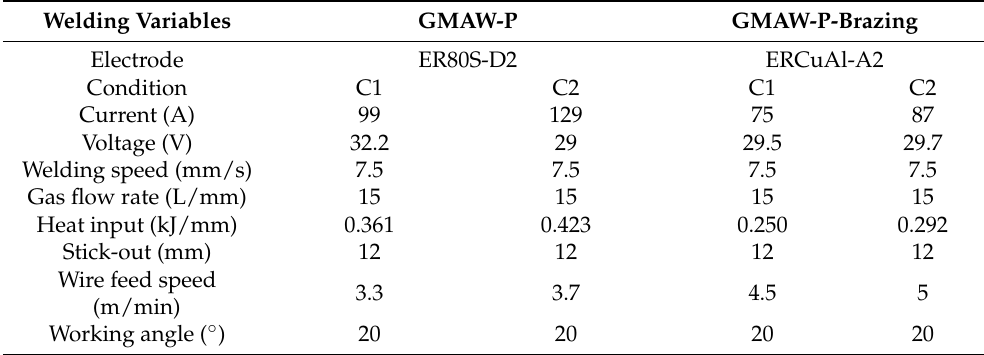
Figure 1. ( a ) Schematic of the lap welded joint and ( b ) fixture holding the sheets and torch angle. Table 2. Welding parameters. Welding Variables GMAW-P